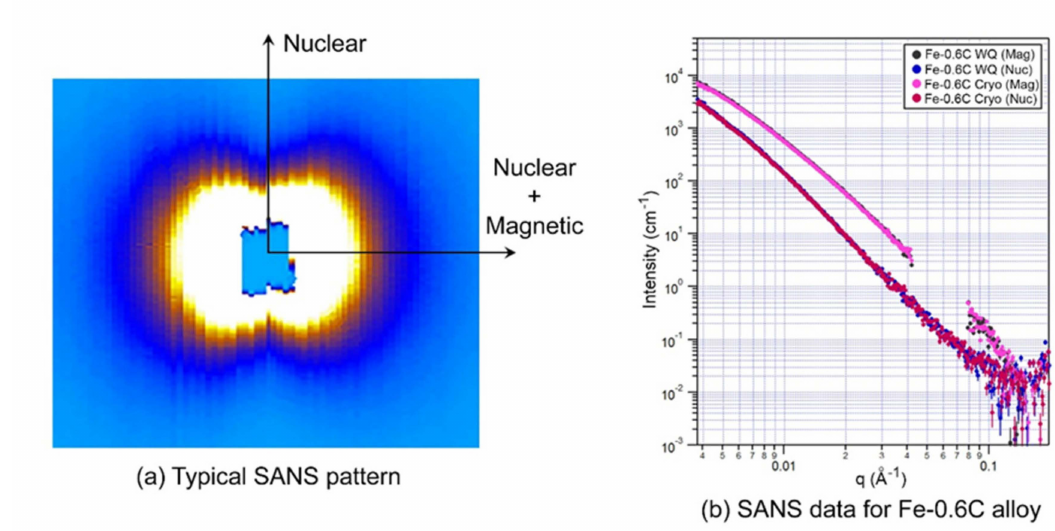
Figure 5. ( a ) Typical scattering pattern obtained from the martensitic alloys. The scattering pattern was measured from a sample during exposure to a 1T magnetic field. ( b ) Nuclear and magnetic scattering signal from martensitic Fe-0.6C alloy in two conditions: water quenched; and water quenched followed by 24 h deep cryogenic